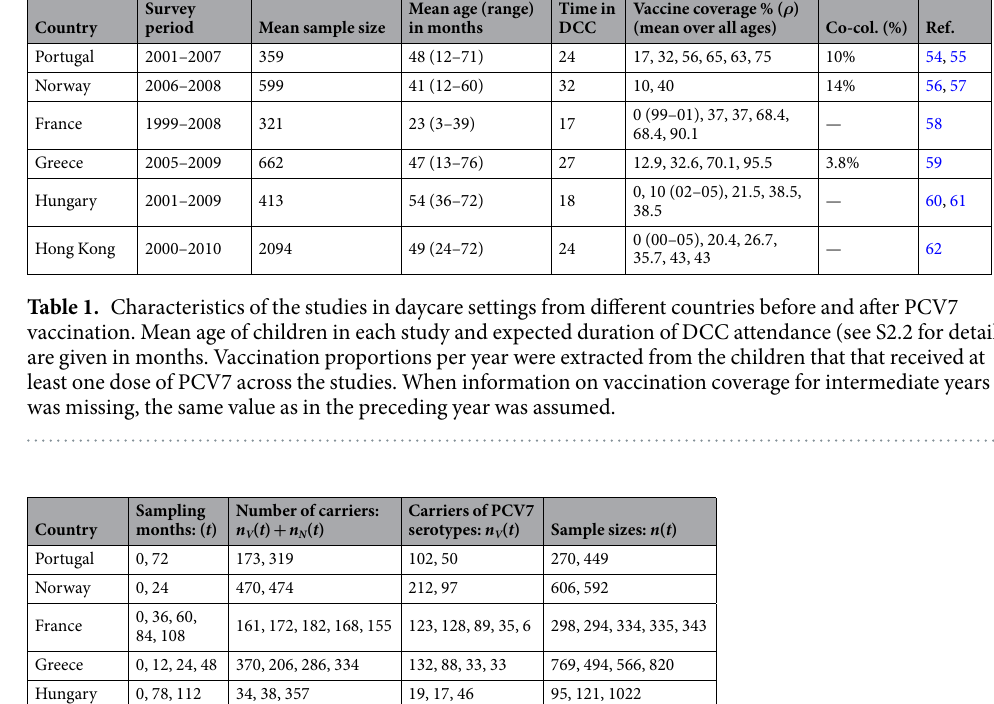
Table 2. Pneumococcus prevalence data from daycare settings in different countries. For Portugal and Norway more data were available and were used than shown here (see Methods